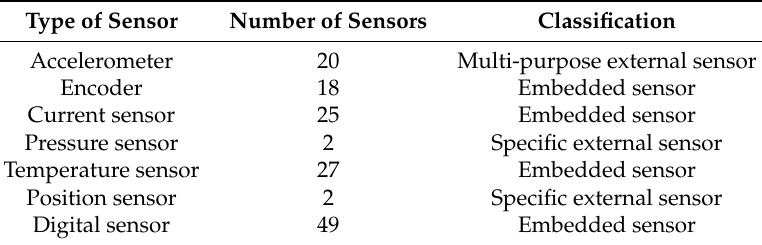
Table 1. On-line data acquired in a single packaging